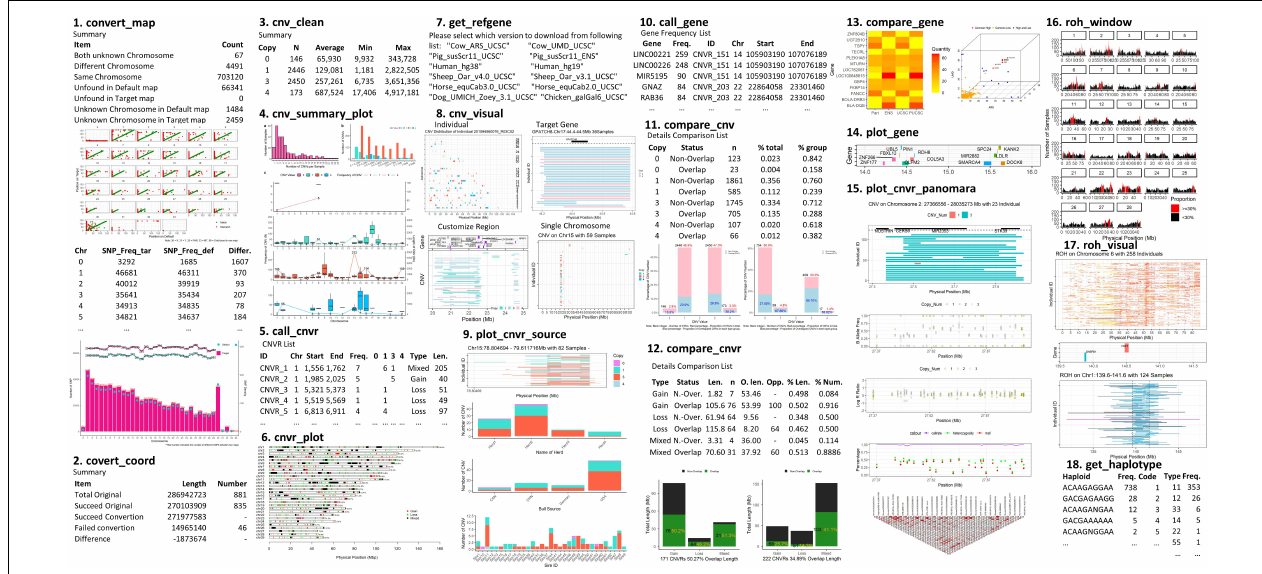
FIGURE 1 | Example plots illustrating the main functions and output from the HandyCNV